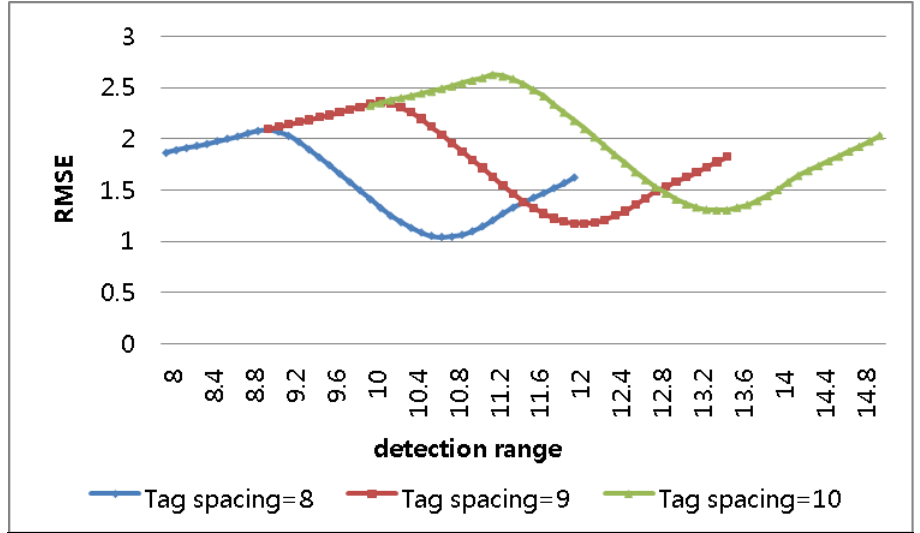
Figure 10. RMSE for detection ranges varying to 150% in 2-dimensional-space numerical approach.